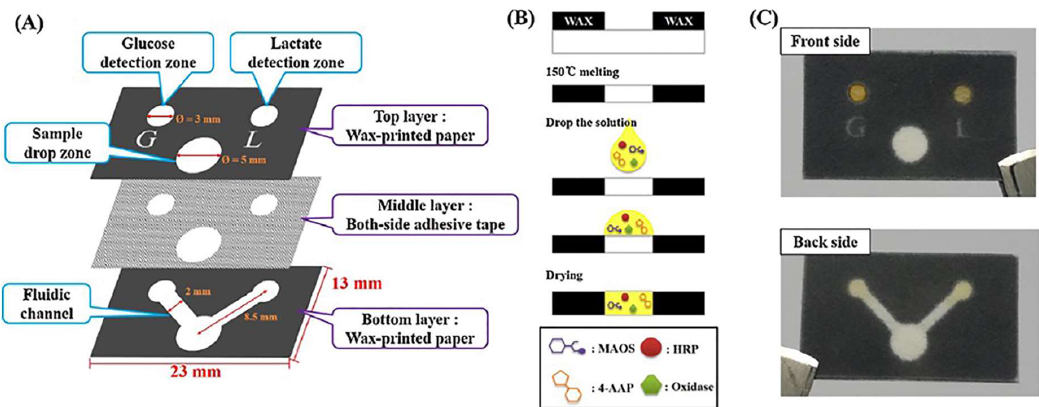
Figure 5. The color change in paper-based sensors can be quantified through the analysis of a picture taken via smartphone. Reproduced with permission from [91]. An overview of the paper-based sensor that was used to detect glucose and lactate. ( a ) Two detection zones and the sample zone are contained in the top layer. The bottom layer contains a fluidic channel, and both of these layers are connected using double-sized adhesive tape. ( b ) The process of wax-printing used to construct the sensor. ( c ) The anterior and posterior sides of the sensor.